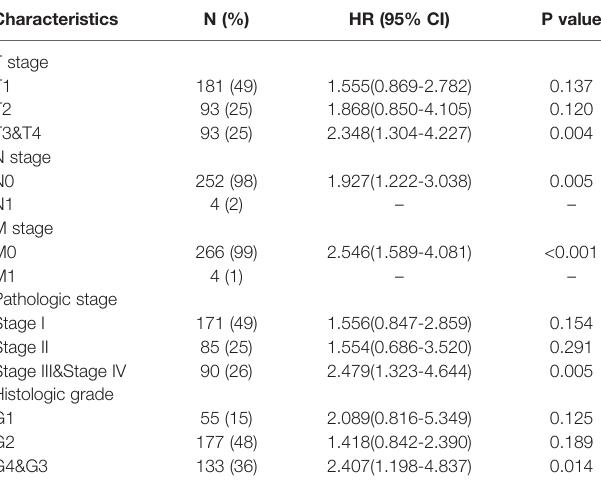
TABLE 4 | The prognostic value of METTL18 (Overall Survival) in diverse hepatocellular carcinoma subgroups. Characteristics